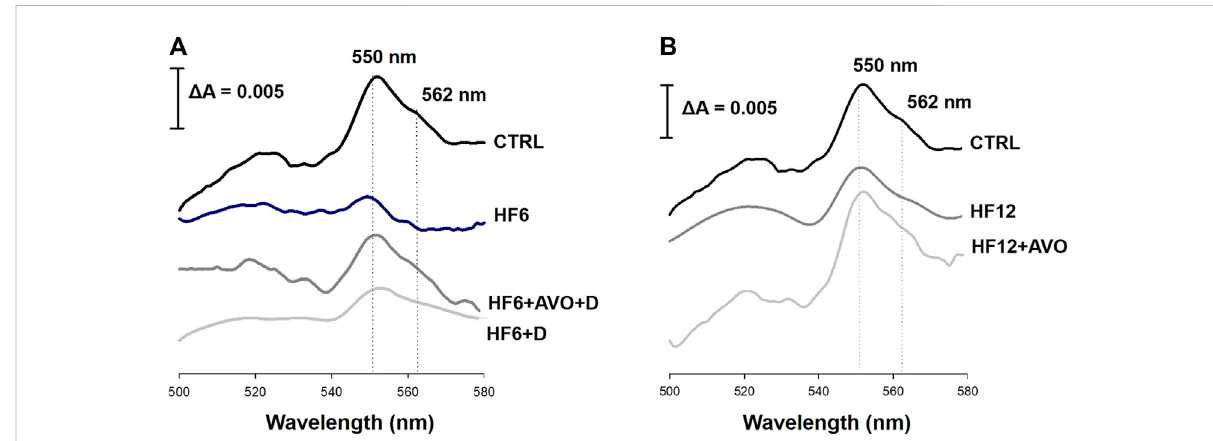
FIGURE 6 Effects of avocado oil on cytochrome spectra of liver mitochondria. Panel (A) spectra from liver mitochondria of the control (CTRL), HF6, HF6+D and HF6+AVO + D groups. Panel (B) spectra from liver mitochondria of the CTRL, HF12 group and the HF12 + AVO groups. Succinate was used as a substrate for the reduction of cytochromes. The spectra are representative of four independent determinations carried out with mitochondrial samples obtained from different animals of each group.